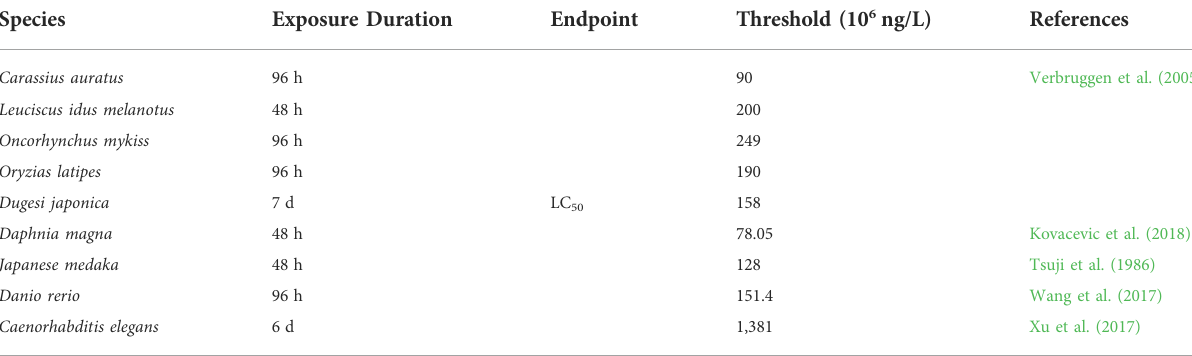
TABLE 1 LC 50 of TCEP to freshwater aquatic organisms.